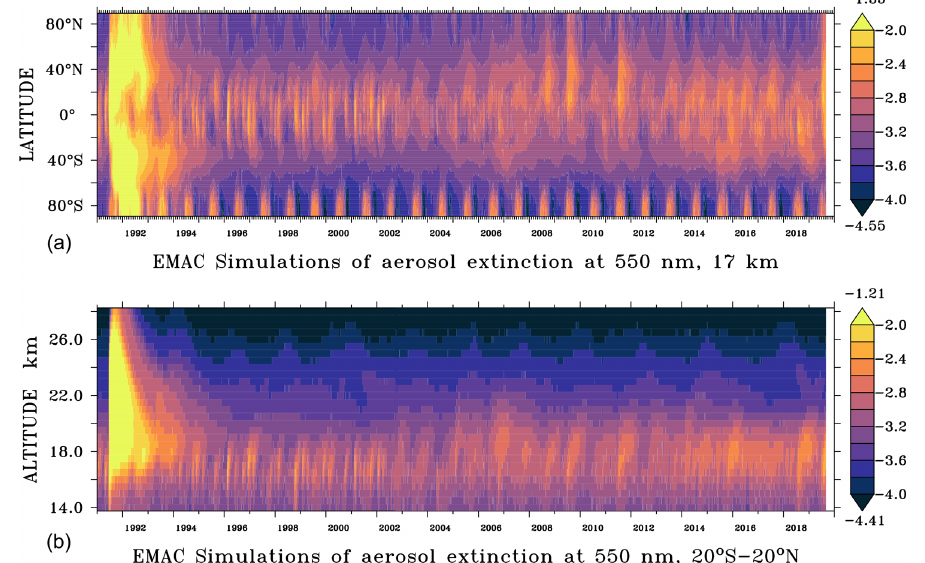
Figure 8. EMAC simulation of the stratospheric aerosol extinction on a logarithmic scale log(km − 1 ) for a 550nm wavelength from Jan- uary 1991 to August 2019 (5d averages), zonal mean at 17km altitude (a) and vertical distribution for tropical regions 20 ◦ S–20 ◦ N (b) . Maximum and minimum values appear above (yellow) and below (dark blue) the colour keys,